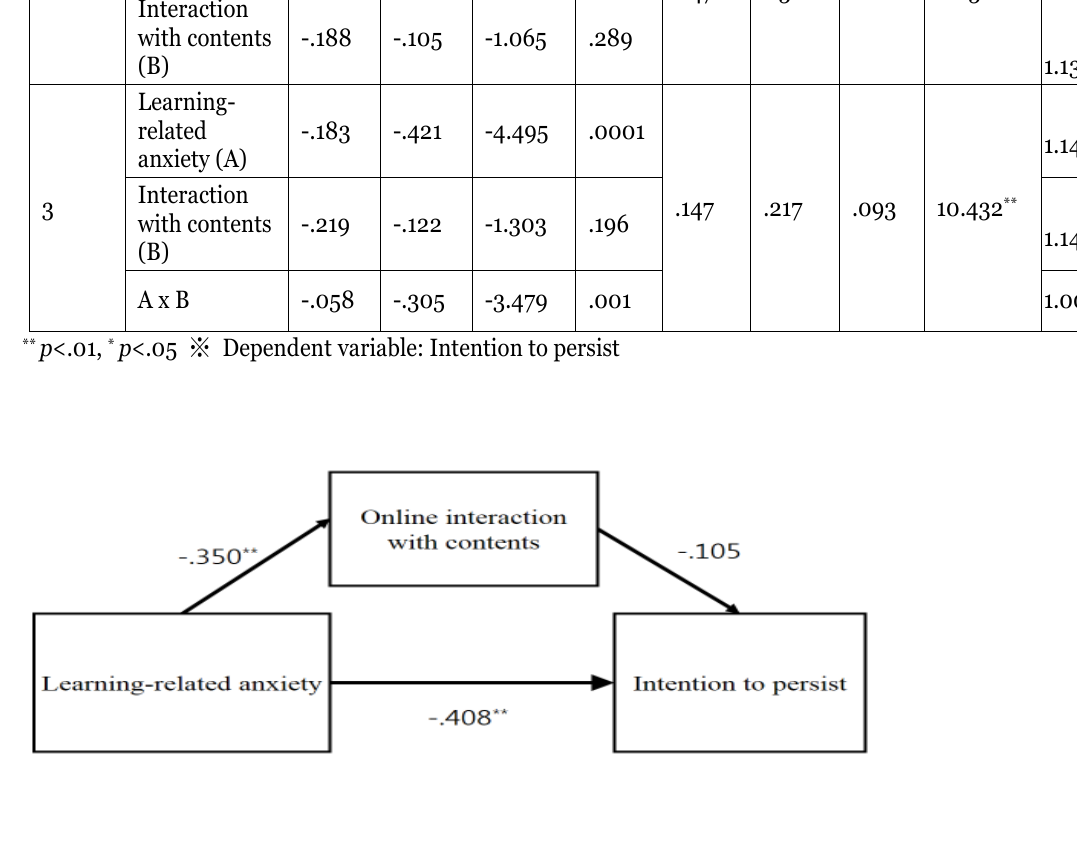
Figure 3. The suppressor role of interaction with